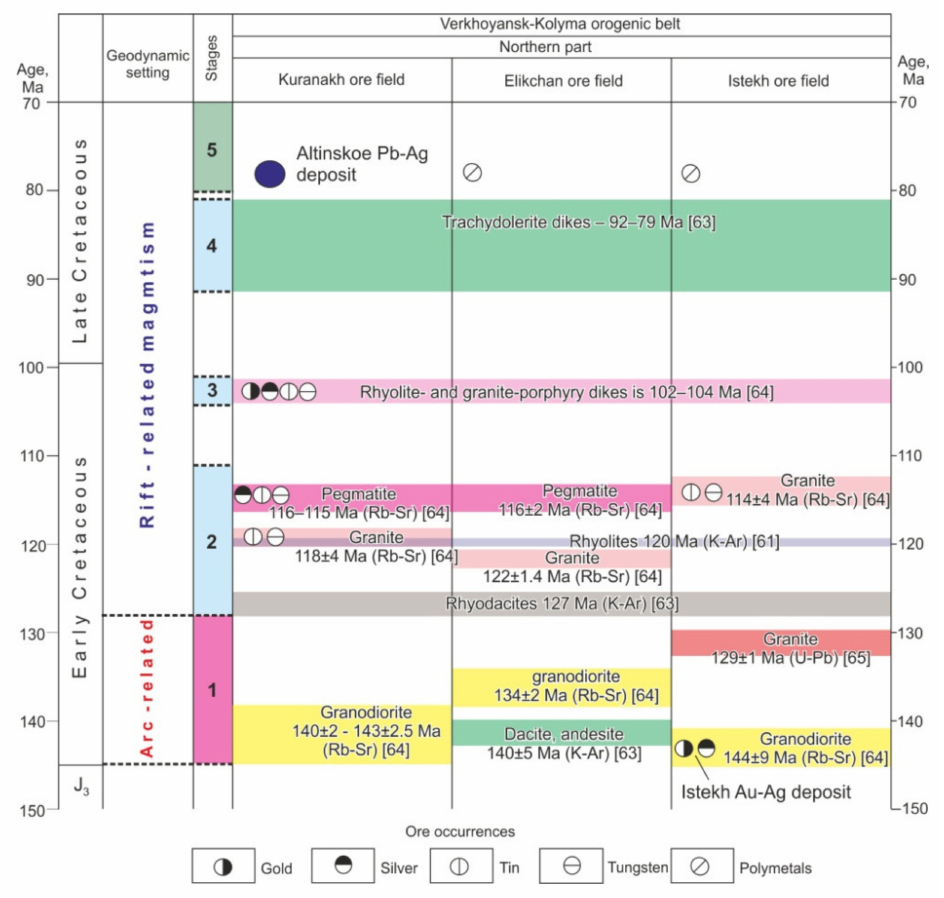
Figure 16. Magmatic, metallogenic and tectonic events in the northern Verkhoyansk–Kolyma oro- genic belt, correlated on the basis of isotopic